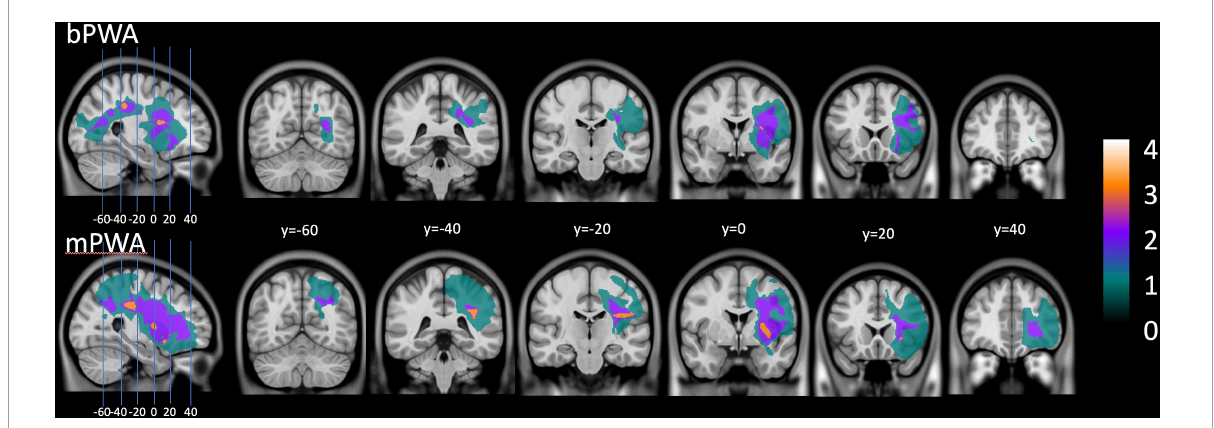
FIGURE1 Lesion overlay plot: on the (upper section) , lesion size for all bilingual participants with aphasia. On the (lower section) , lesion size averaged for all monolingual participants with aphasia.